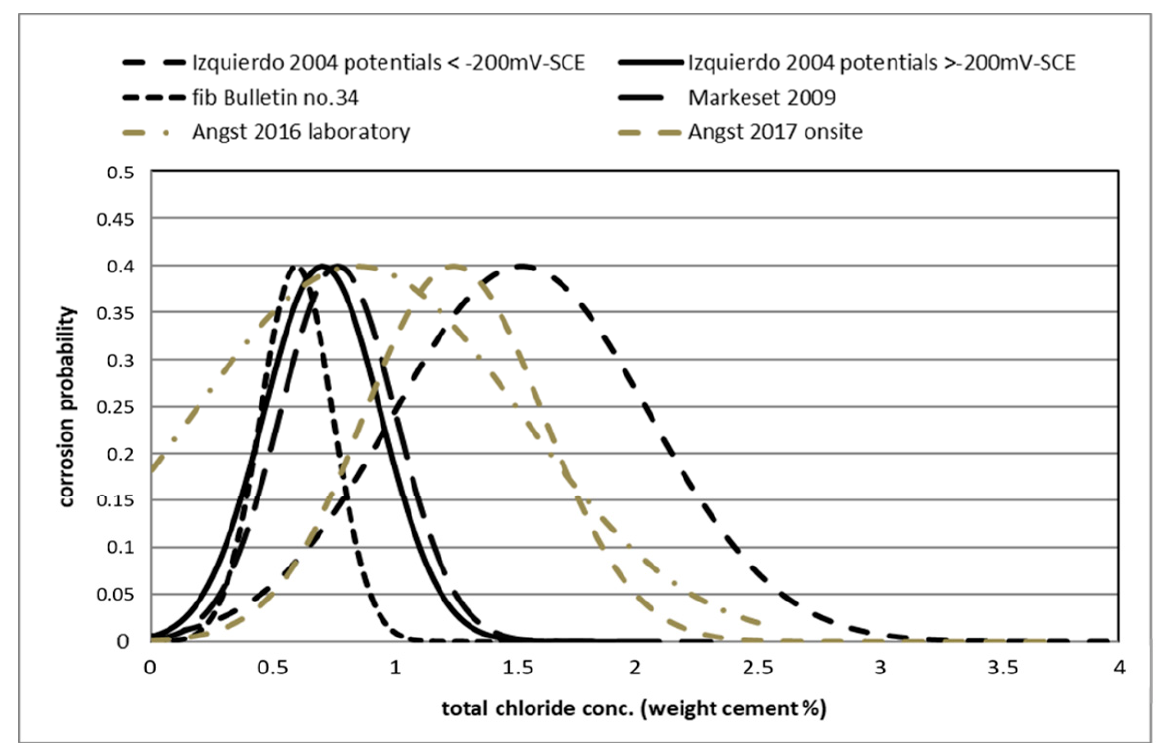
Figure 8. Some statistical distributions of the chloride threshold [5,10,14,15,21] showing the variability of the distributions, that however are of them within the limits shown in Figure